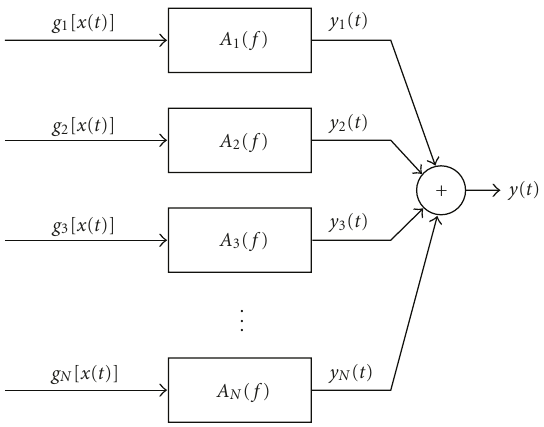
Figure 2: MISO model for nonlinear system identification with the input signals g n [ x ( t )] and the linear filters A n ( f ), n ∈ [1, N ].